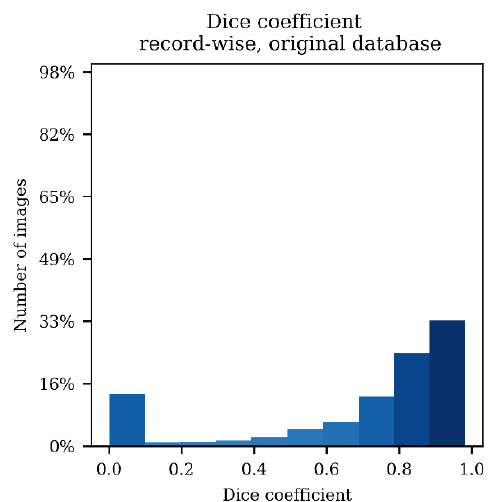
Figure A1. Dice coefficient histogram for segmentation results on a test set for a network trained on the original database with 5 -fold record-wise cross-validation.